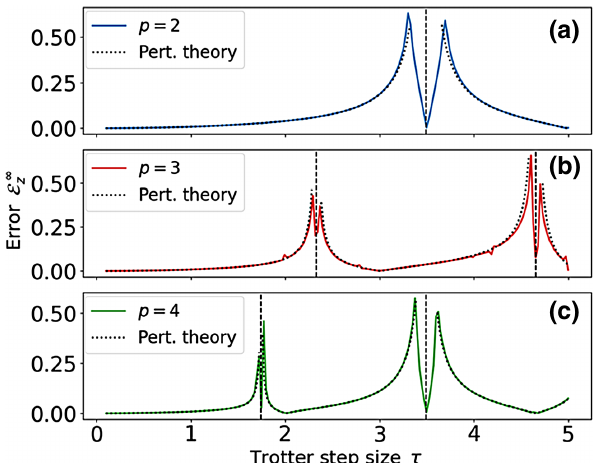
FIG. 2. Error in the long-time-averaged magnetization along and defined in Eq. (18), for (a) the z axis, denoted by E ∞ z p = 2, (b) p = 3, and (c) p = 4, with N = 256. The dotted lines represent time-averaged magnetization predicted from the non- degenerate first-order unitary perturbation theory, which agree well with numerically obtained values except in the immediate vicinity of the center of the structural instability region where the nonperturbative term e i ( 1 − s )τ J z becomes degenerate. The ver- tical dashed lines are located at the center of structural instability regions, as predicted by unitary perturbation